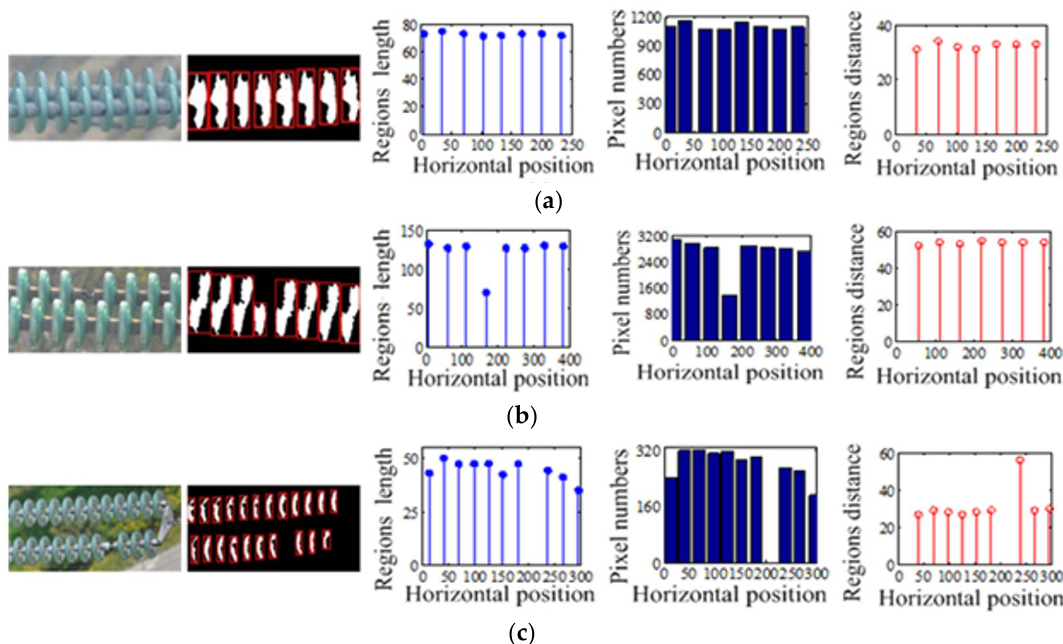
Figure 5. Spatial features of connected regions: ( a ) Normal; ( b ) Self-shattering with obstruction; ( c ) Self-shattering without obstruction.